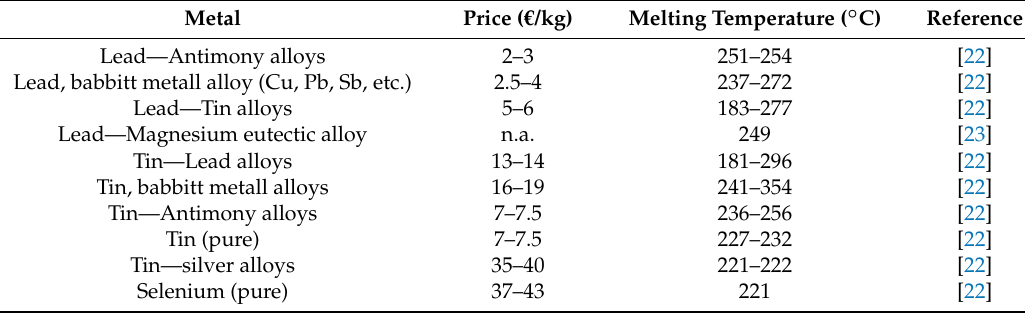
Table 2. Metal PCM candidates with phase change temperature between 210 ◦ C and 270 ◦